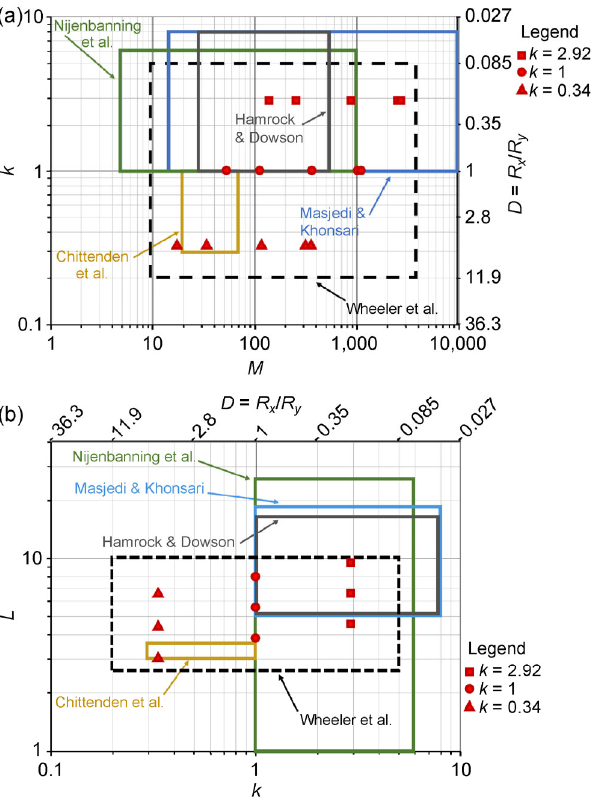
Fig. 4 Domains on which EHD film thickness equations for elliptical contacts were established. The black bold dotted line indicates the region where the full numerical model was applied in Ref. [11]. The square and triangle show the ranges on which the comparison was conducted for two elliptical configurations defined by k =2.92 and 0.34 (or D = 0.2 and 5), respectively: (a) expressed in M – k / D chart, and (b) expressed in k / D – L